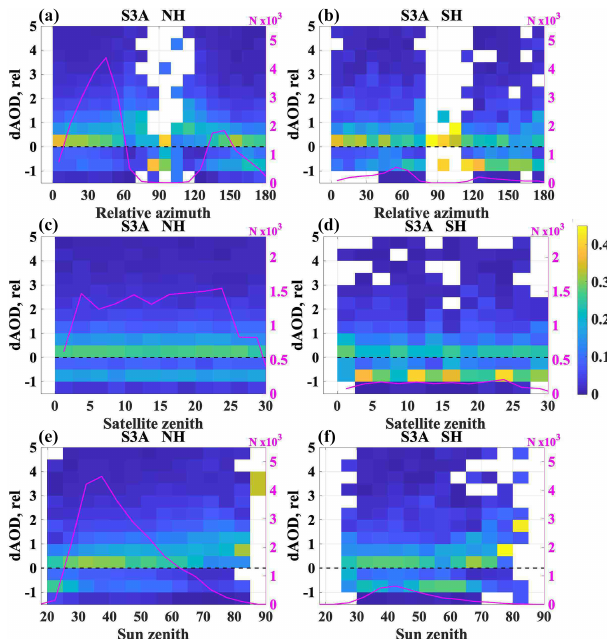
Figure 11. For S3A syAOD matchups with AERONET which do not satisfy GCOS requirements, the dependence of the AOD rela- tive offsets on relative azimuth (a, b) , satellite zenith angle (c, d) , and sun zenith angle (e, f) for the NH (a, c, e) and SH (b, d, f) for all pixels. Colour indicates the fraction of the points with correspond- ing dAOD,rel from the total number of points within the x -axis bin. The magenta line shows the total number of matchups in the corre- sponding x -axis bin.